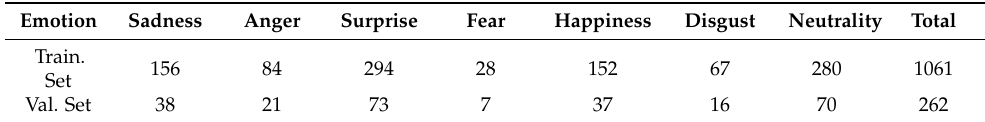
Table 1. Data statistics of the S70 subset of the CDESD Dataset. Emotion Sadness Anger Surprise Fear Happiness Disgust Neutrality Total 156 84